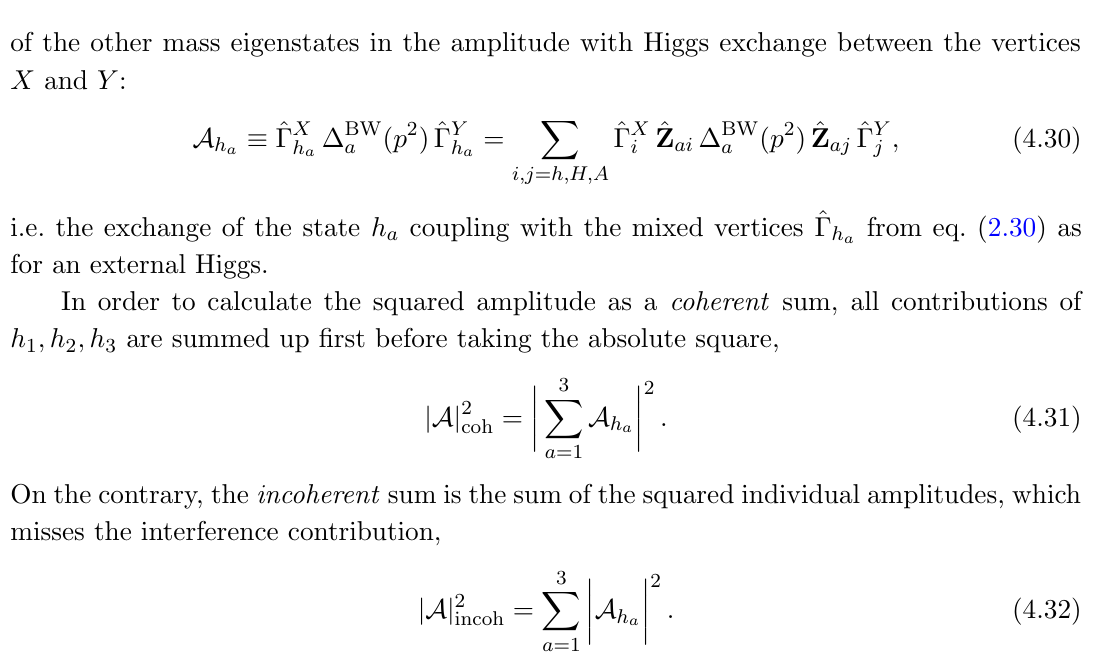
Figure 4 . Diagrammatic representation of the contribution A h to the amplitude A . The blue lines labelled by h a denote the Breit-Wigner propagator (cid:1) BW and the green lines labelled by i; j = h; H; A denote lowest order propagators of h; H; A